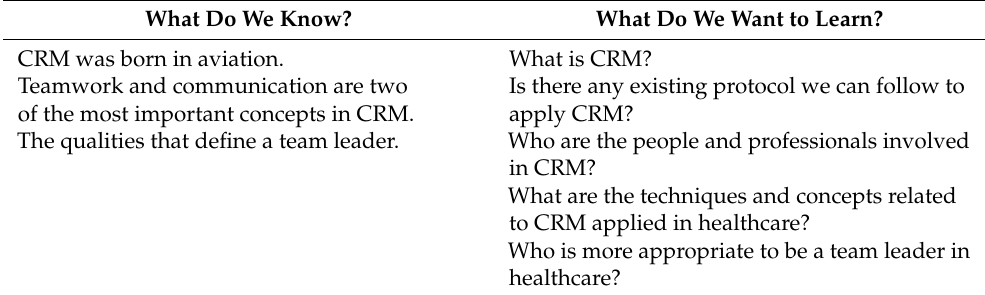
Table 2. Baseline learning